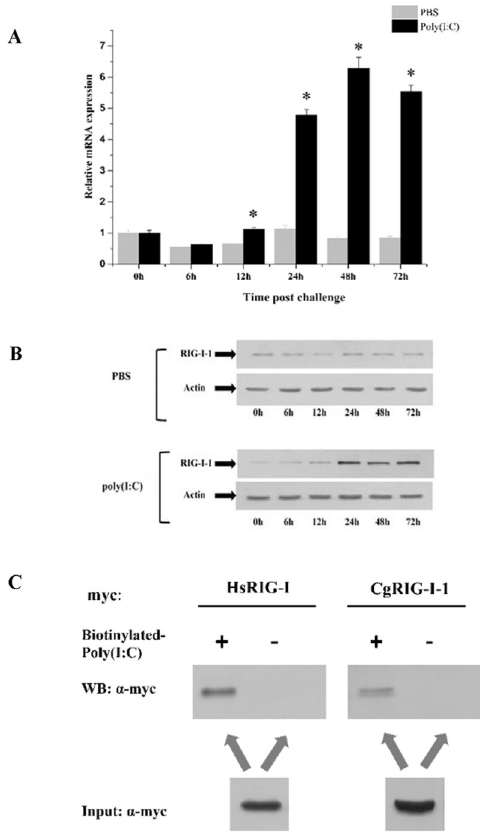
Figure 3. CgRIG-I-1 responds to poly(I:C) challenge and binds poly(I:C) in vitro . ( A and B ) Expression profiles of CgRIG-I-1 after poly(I:C) challenge analysed by quantitative real-time PCR (qRT-PCR) and western blot, respectively. qRT-PCR was performed in triplicate for each sample using the β -actin gene as an internal control. Expression levels were determined using the 2 −ΔΔ CT method. The expression level at 0 h post PBS injection was set as baseline (1.0). Vertical bars represent the mean ± SD (N = 3). * P < 0.05, between challenged and control at the same time point. ( C ) Poly(I:C) pull-down assay demonstrating that CgRIG-I-1 can bind poly(I:C) in vitro